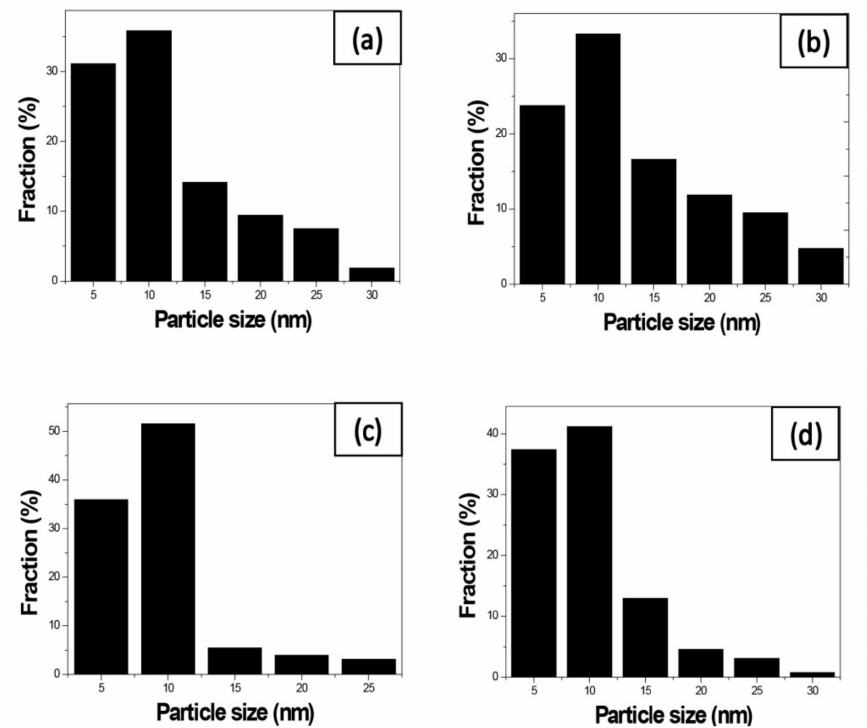
Figure 3. Size distribution of the nanocomposites. Size distribution of ( a ) 5.34% silver nanoparticle- embedded graphene oxide (Ag / rGO), ( b ) 7.49% Ag / rGO, ( c ) 6.85% zinc oxide nanoparticle- embedded graphene oxide (ZnO / rGO), and ( d ) 16.45% ZnO / rGO. Data are representative of two separate